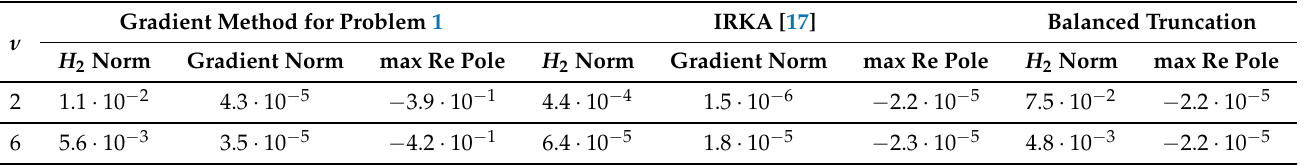
Table 1. Comparison of the gradient method-based solution of Problem 1 with algorithm (31) vrs. IRKA and balanced truncation, with an arbitrary set of interpolation points.